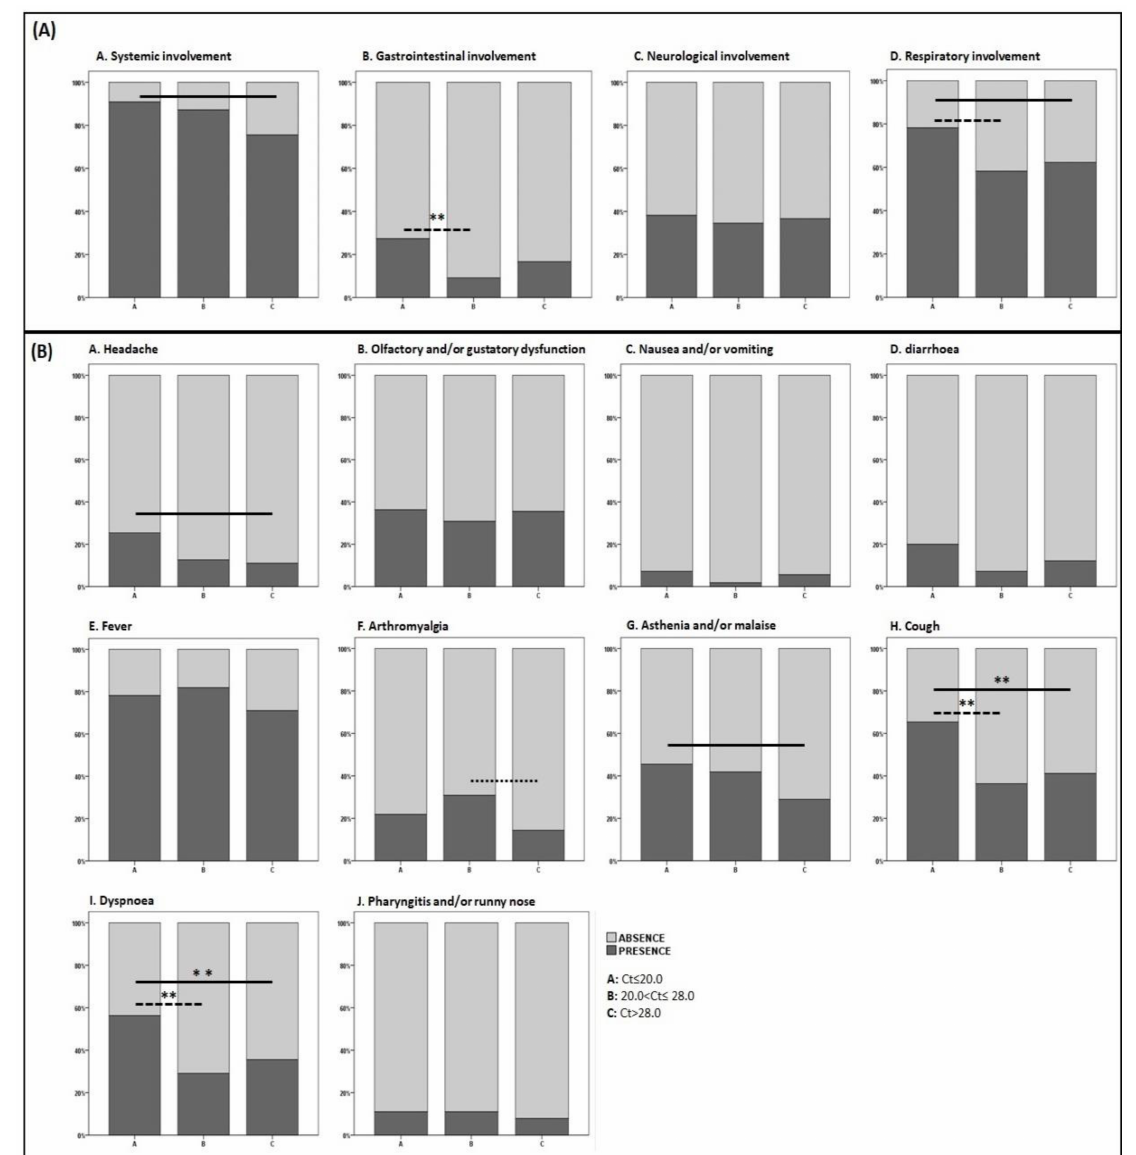
Figure 1. Signs and symptoms of COVID-19 at diagnosis, individual and pooled for main categories according to SARS- CoV-2 Cycle threshold. Only significant differences (Mann–Whitney) are shown as bars in the figure. Pooled signs and symptoms. (Panel A ) ( A ) Group A 50 (90.9%) vs. Group C 68 (75.5%), p = 0.022; ( B ) Group A 15 (27.3%) vs. Group B 5 (9.1%), p = 0.014 **; ( D ) Group A 43 (78.2%) vs. Group B 32 (58.2%), p = 0.025 and Group A 43 (78.2%) vs. Group C 56 (62.2%), p = 0.046. Individual signs and symptoms. (Panel B ) ( A ) Group A 14 (25.4%) vs. Group C 10 (11.1%), p = 0.025; ( F ) Group B 17 (30.9%) vs. Group C 13 (14.4%), p = 0.018; ( G ) Group A 25 (45.4%) vs. Group C 26 (28.9%), p = 0.043; ( H ) Group A 36 (65.4%) vs. Group B 20 (36.4%), p = 0.002 ** and vs. Group C 37 (41.1%), p < 0.005 **; ( I ) Group A 31 (56.4%) vs. Group B 16 (29.1%), p = 0.004 ** and vs. Group C 32 (35.6%), p = 0.015 **. After Bonferroni correction significance was deemed retained by those comparisons with a p -value < 0.016 only (highlighted by